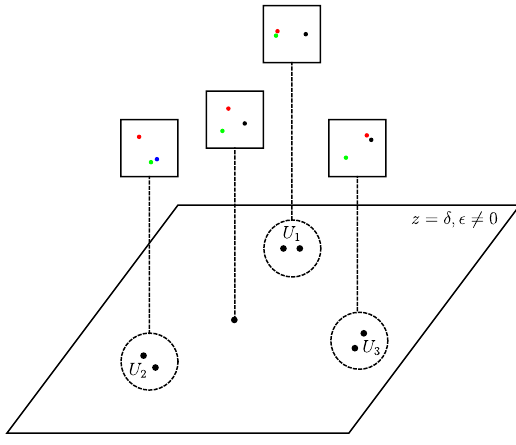
Figure 5 . A picture of the G 2 case for the elliptic (cid:12)bration over the z = (cid:14) plane while (cid:15) 6 = 0. U 1 , U 2 and U 3 are three regions such that eq. (2.21), (2.22) and (2.23) hold to the order O ( (cid:26) 1 2 ), respectively. In these regions the (cid:12)ber becomes nearly degenerate. The red dot represents the root x 1 , the green dot x 2 and the blue dot x 3 . The central node on the z = (cid:14) plane is at arbitrary position as long as it is away from the region where the (cid:12)ber becomes